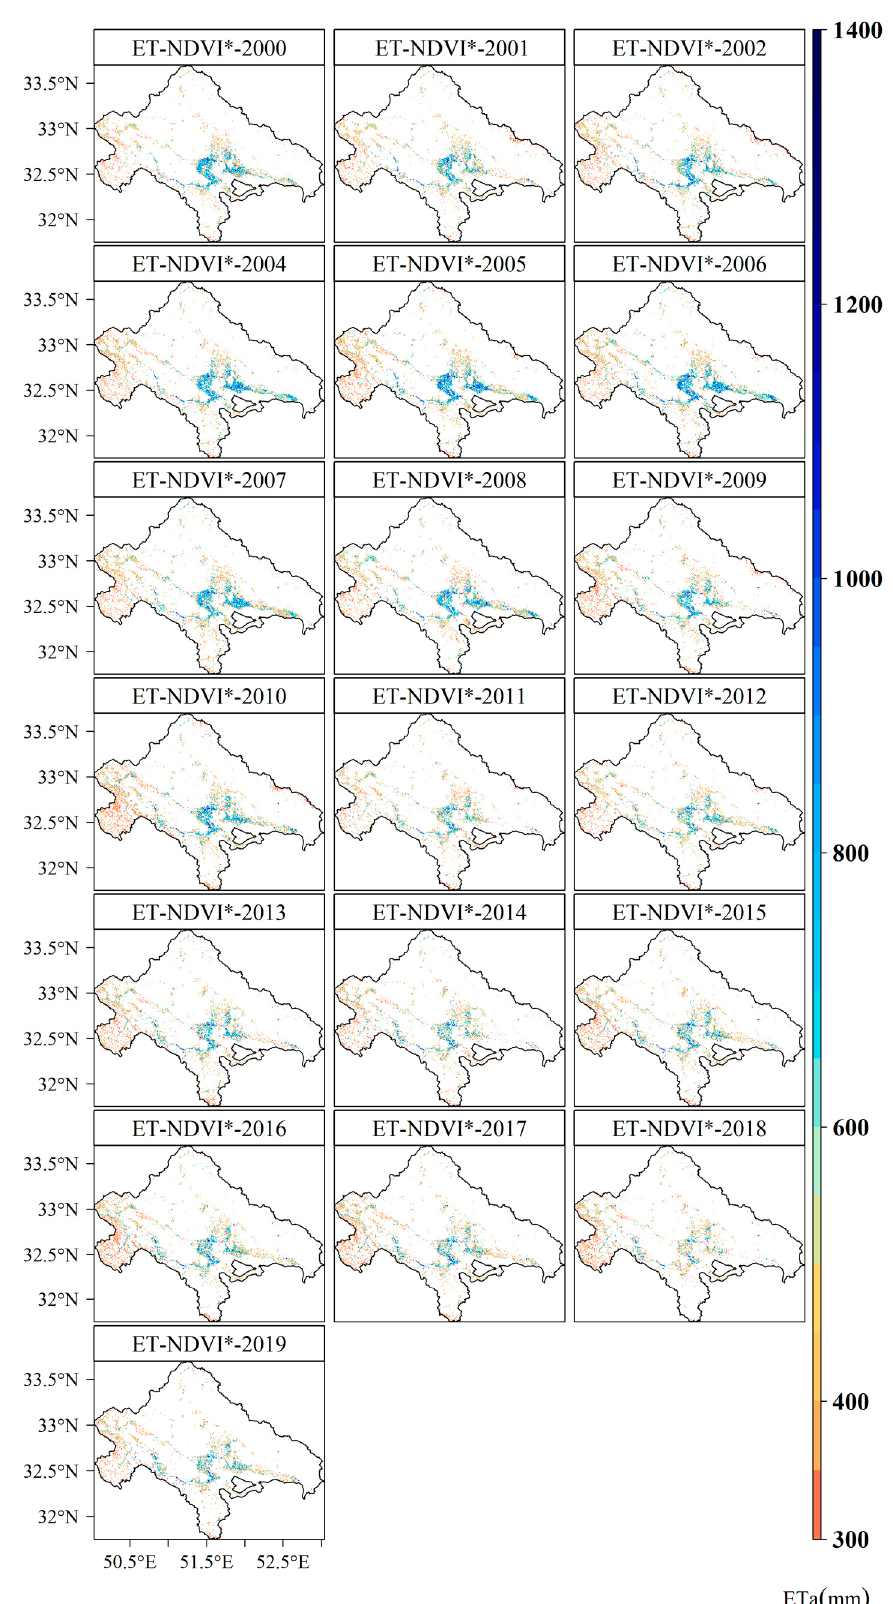
Figure A1. Number of images during study period (2000–2019) .